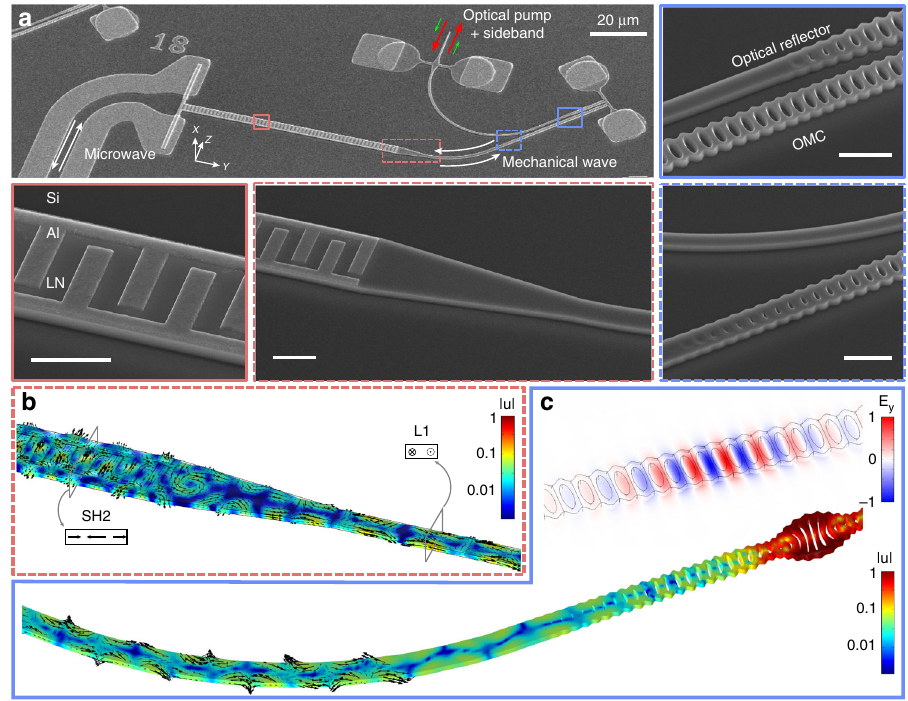
Fig. 1 Design of lithium niobate piezo-optomechanical transducers. a Scanning electron micrographs (SEM) of one piezo-optomechanical transducer. Zoomed-in SEMs show the conversion region between microwave and mechanics (red) and between mechanics and optics (blue). The tapers between the IDT and the mechanical waveguide (dashed red) and between the optomechanical crystal and the waveguide (dashed blue) are also shown in detail. All scale bars in zoomed-in SEMs are 2 µ m. b Finite-element simulation of the IDT-to-waveguide taper (normalized displacement). Second-order horizontal shear mode (SH2) in the IDT and fi rst-order longitudinal mode (L1) in the waveguide are indicated. c Finite-element simulations of the OMC optical mode (transverse E component) and the leaky mechanical mode (normalized displacement). First-order longitudinal motion in the waveguide can be observed for both the IDT and the leaky OMC mechanical mode.